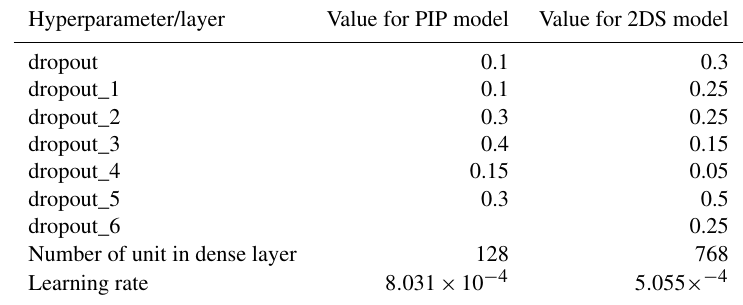
Table A1. Hyperparameter tuning results for each probe.